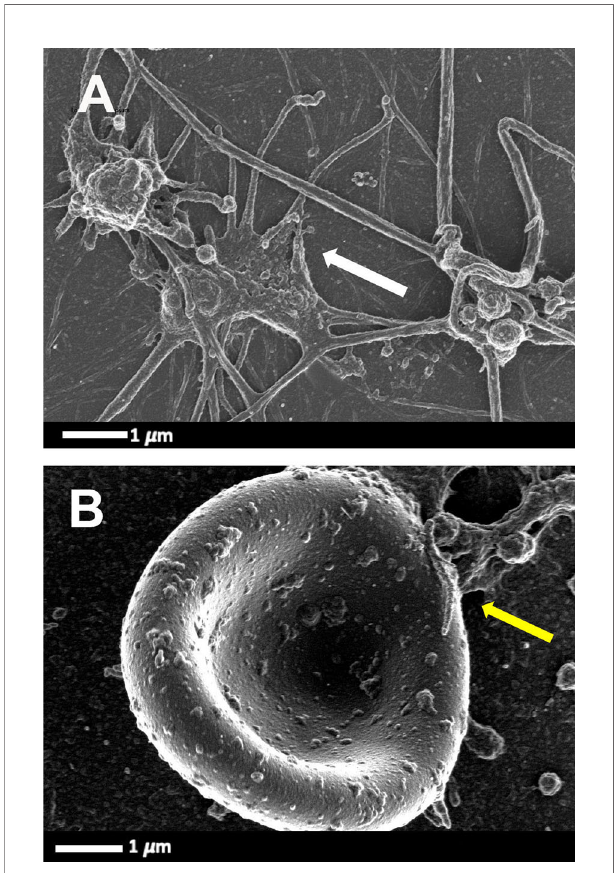
FIGURE 2 | Scanning electron microscopy micrograph plate from patients with HIV and with deep vein thrombosis and on primary treatment (emtricitabine, tenofovir and efavirenz) (cART). (A) Hyperactivated platelets with pseudopodia, spreading and microparticle formation (white arrow). (B) Platelet-erythrocyte complex, yellow arrow: platelet forming pseudopodia that attaches to an erythrocyte membrane (raw data taken from